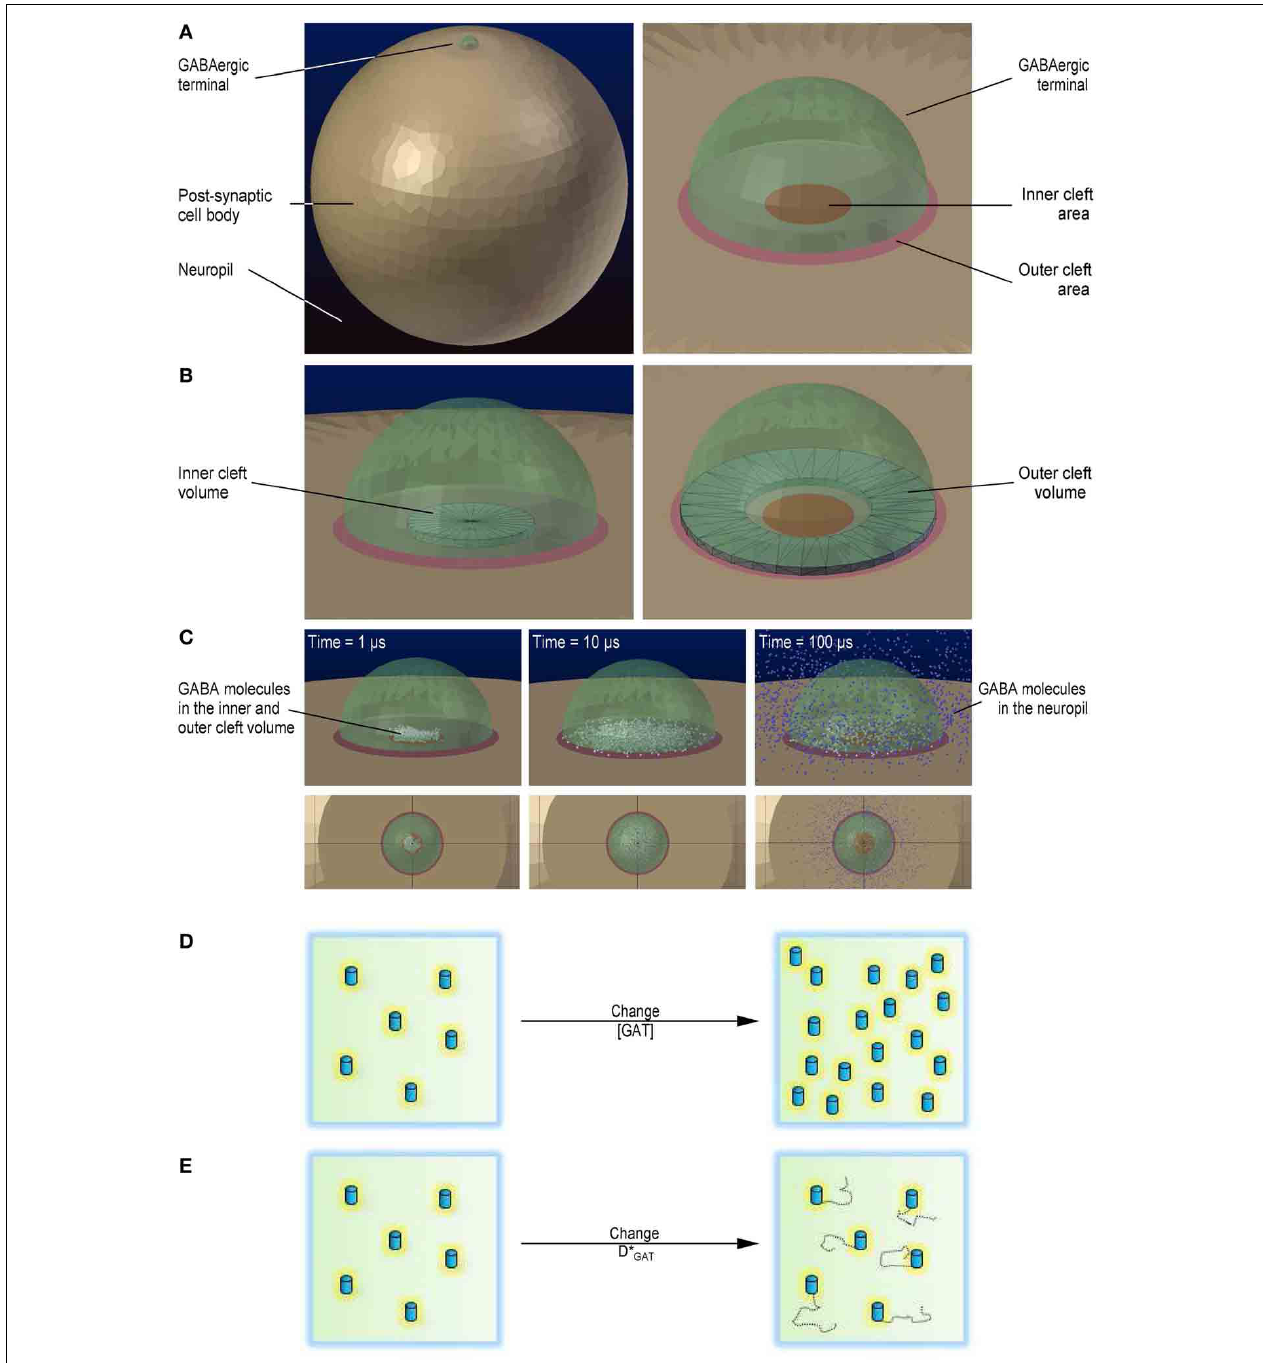
FIGURE 1 | 3D geometry of the modeled simulation environment. (A) Geometry of the simulation environment used to run the Monte Carlo reaction-diffusion simulations in CellBlender (left). The large light brown sphere represents the cell body of a post-synaptic cell. The small green, semi-transparent hemisphere represents an axo-somatic GABAergic synaptic terminal. The dark blue background represents the neuropil. Close-up view of the presynaptic terminal, including the inner and the outer cleft areas (right). The red circle represents the inner cleft area. The pale red annulus represents the outer cleft area. (B) The black wireframe shows the portion of the synaptic cleft volume above the inner cleft area in which we monitored the